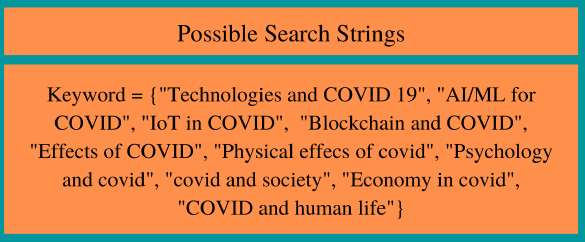
Figure 1. Search strings.